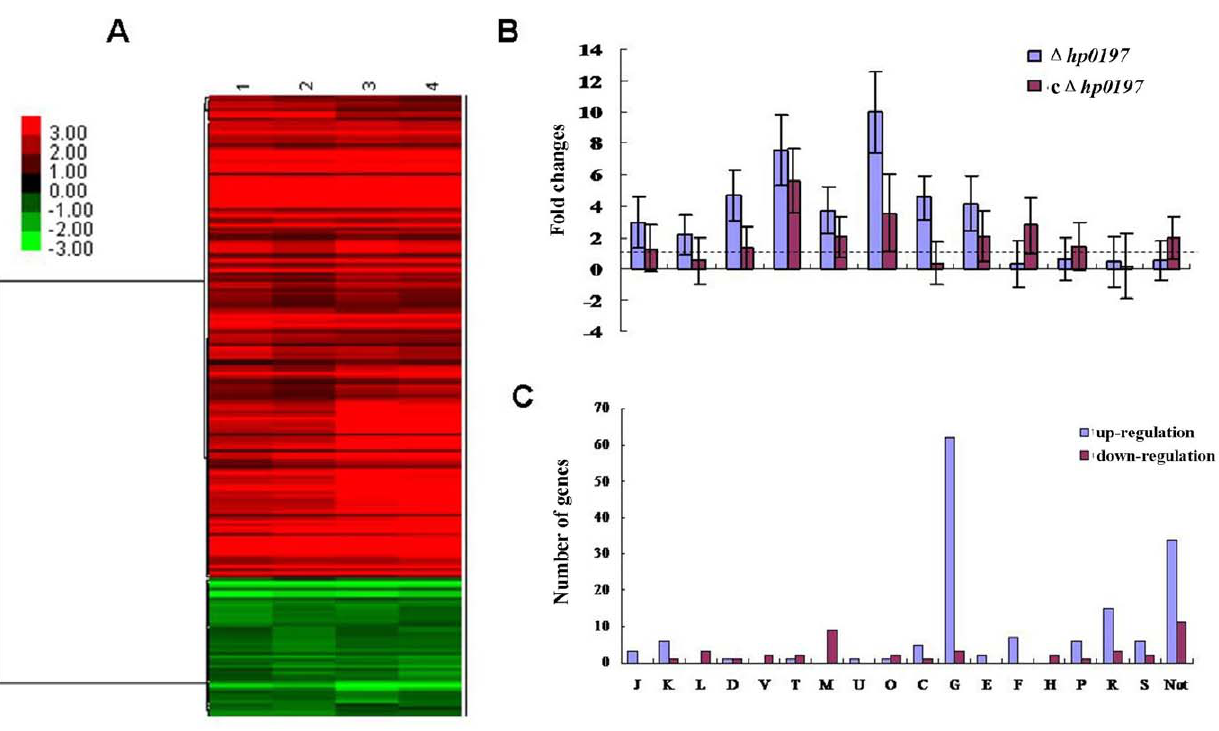
Figure 4. Microarray-based comparative transcriptomic analysis of D hp0197 and WT strains. ( A ) Microarray-based comparative transcriptomic analysis of D hp0197 and WT strains. A hierarchical cluster of 193 transcripts in the D hp0197 compared to the WT strain. The increased and decreased transcript expression levels were indicated by red and green, respectively. ( B ) Different expression profiles identified by microarray analysis were validated by qRT-PCR based on the data obtained from a total of 12 genes. From left to right: ssu05_1372, ssu05_1933, ssu05_0167, ssu05_2076, ssu05_2137, ssu05_1039, ssu05_0360, ssu05_1401, ssu05_0812, ssu05_0573 ( cps 2J ), ssu05_0265 and ssu05_0469. ( C ) Functional classification of the differentially expressed genes. J: Translation, ribosomal structure and biogenesis; K: Transcription; L: Replication, recombination and repair; D: Cell cycle control and cell division; V: Defense mechanisms; T: Signal transduction mechanisms; M: Cell membrane and envelope biogenesis; U: Intracellular trafficking, secretion and vesicular transport; O: Posttranslational modification, protein turnover, chaperones; C: Energy production and conversion; G: Carbohydrate transport and metabolism; E: Amino acid transport and metabolism; F: Nucleotide transport and metabolism; H: Coenzyme transport and metabolism; I: Lipid transport and metabolism; P: Inorganic ion transport and metabolism; Q: Secondary metabolites biosynthesis, transport and catabolism; R: General function prediction only; S: Function unknown; Not: Not in COGs.